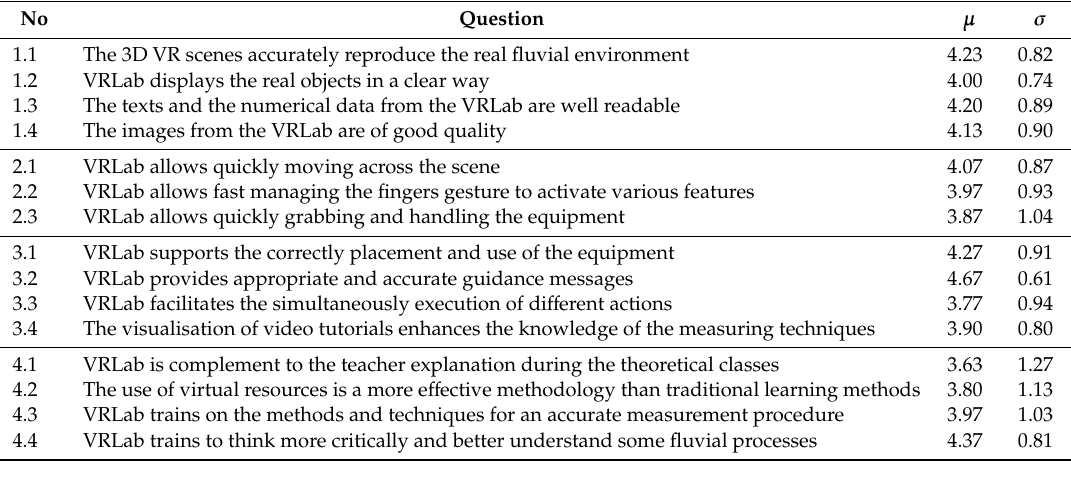
Table2. Valuesofmean, µ , andstandarddeviation, σ , basedonthescoresobtainedfromthequestionnaire.